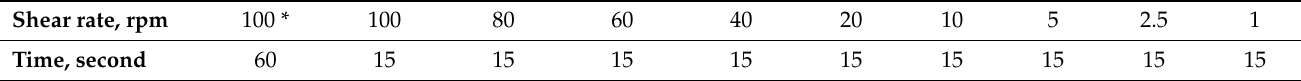
Table 3. Testing